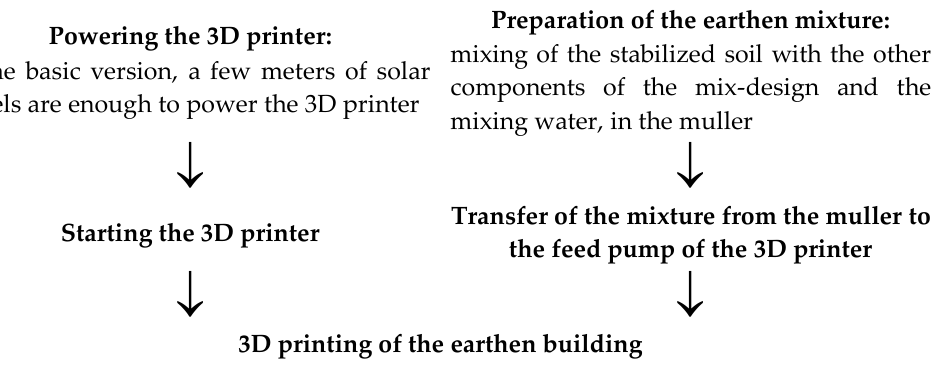
Figure 4. Flowchart of the 3D-printing process for earthen construction.